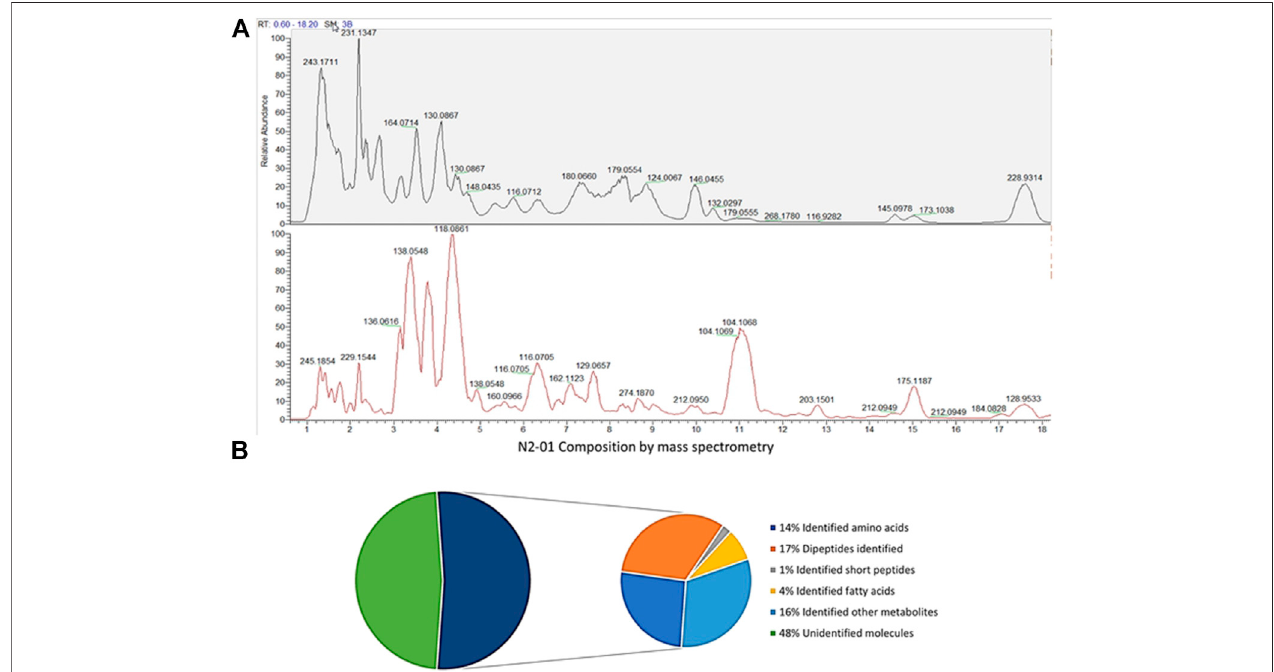
FIGURE1| N2-01compositionbymass-spectrometry. (A) PercentageoftotalionintensityexplainedbyCompoundDiscovererandPEAKSforproductionbatches 4, 5 and 6 combined. (B) Chromatogram of batch 6, negative mode top, positive mode